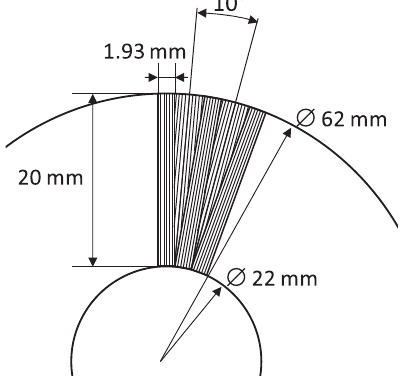
FIG. 4. Schematic pattern for the laser treatment of the QPR sample LESS1, repeated along the entire annular surface.